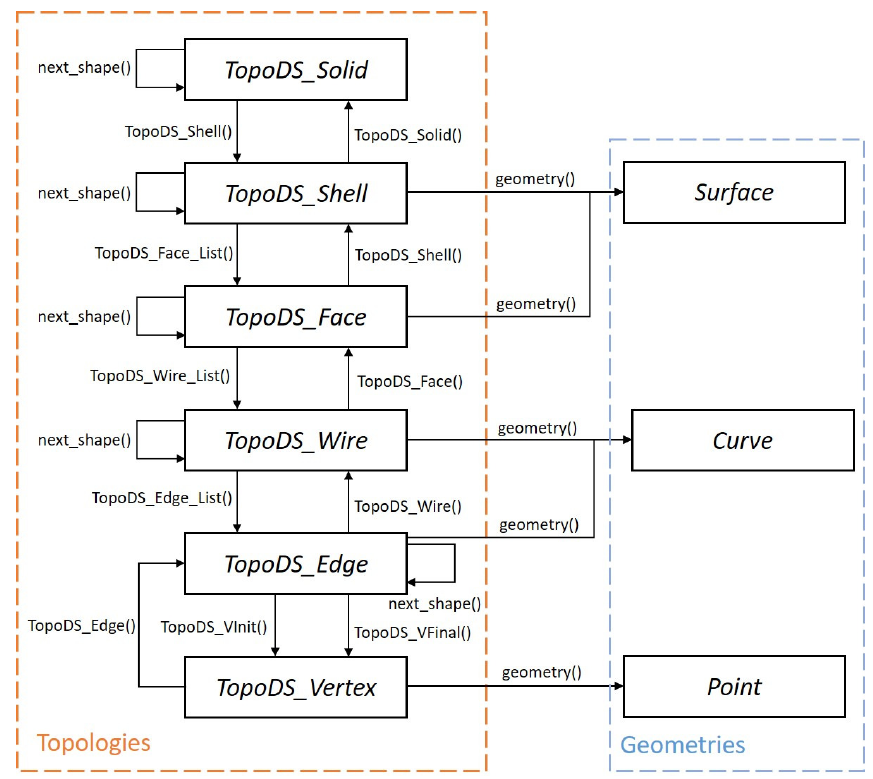
Figure 7. Original geometry-topology data structure, using OpenCascade TM data names (which differ but are mathematically equivalent to ACIS TM terms)-see Ref. [2] from same